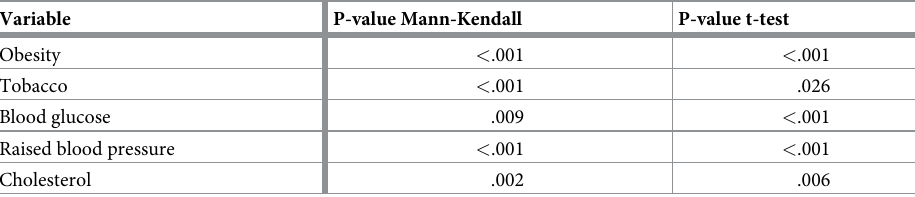
Table 1. Mann-Kendall test and t-test